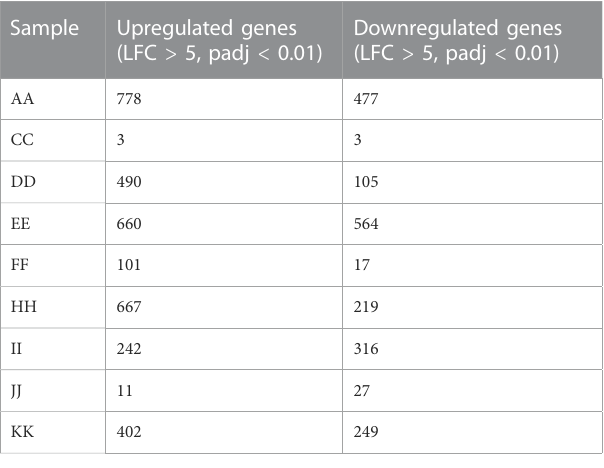
TABLE 4 Differentially expressed genes amongst the OVCa